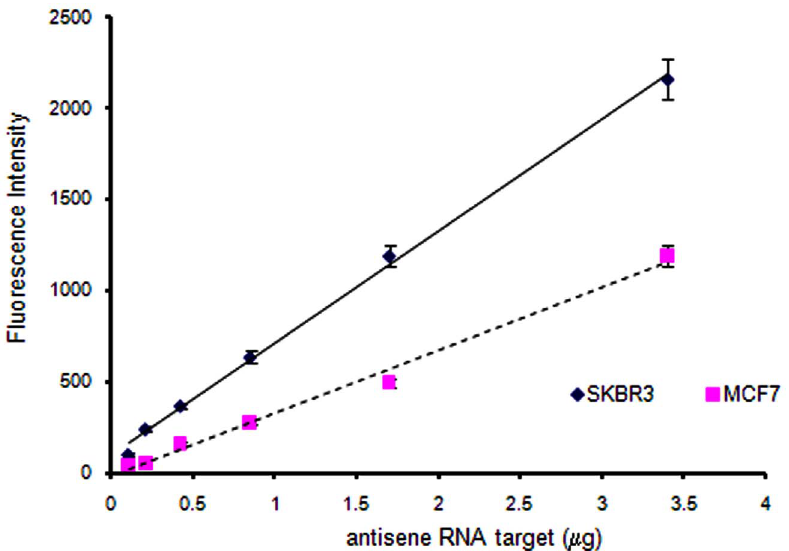
Figure 7. Fluorescence bead assay of HER2 cRNA from SKBR3 and MCF7 cell lines with PNA probe P6.